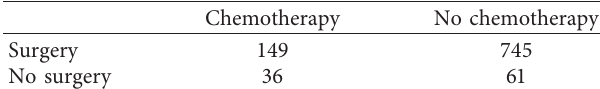
Table 4: Summary of treatment: multimodality treatment with